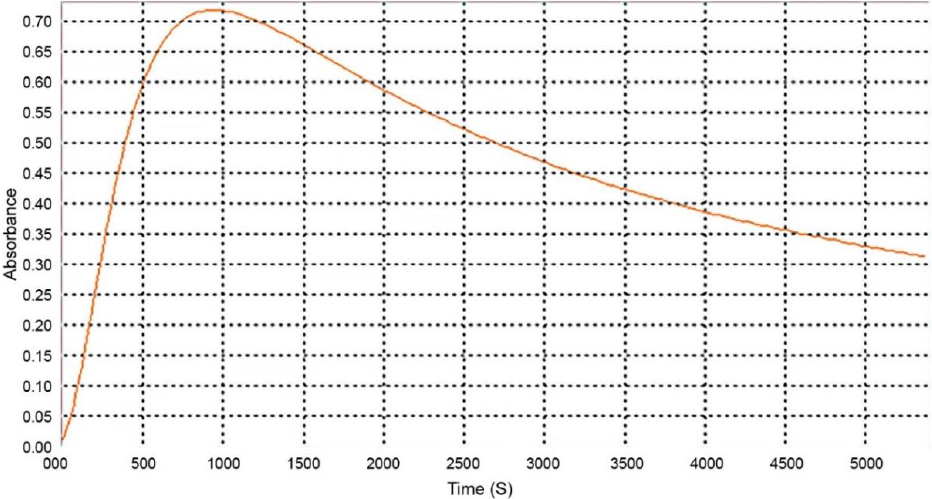
Figure 4. Optimization of the ratio of cholesterol at 0.5 mmol/L and the Liebermann – Burchard reagent at 620 nm.